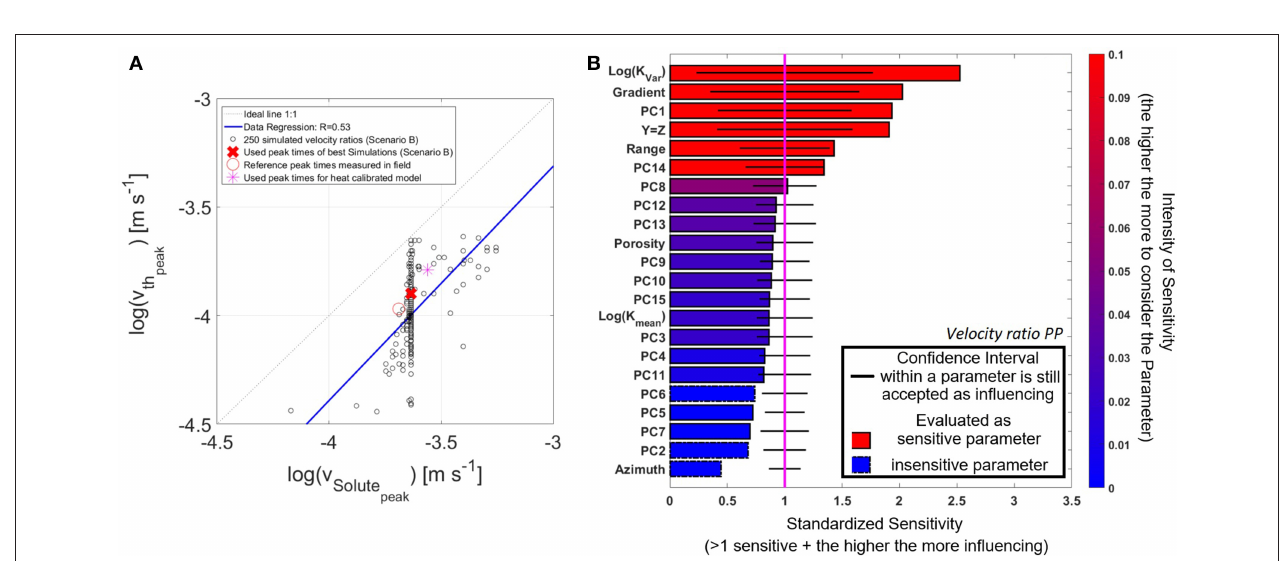
FIGURE 8 | (A) Velocity ratio v heat /v sol comparison using the peak times of the heat and solute breakthroughs generated with Monte-Carlo using Scenario B (K-Trend). (B) Sensitivity results using the derived velocity ratio v heat /v sol as prior responses for